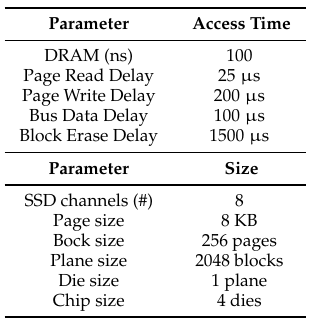
Table 3. SSD (solid state drive) operational settings.